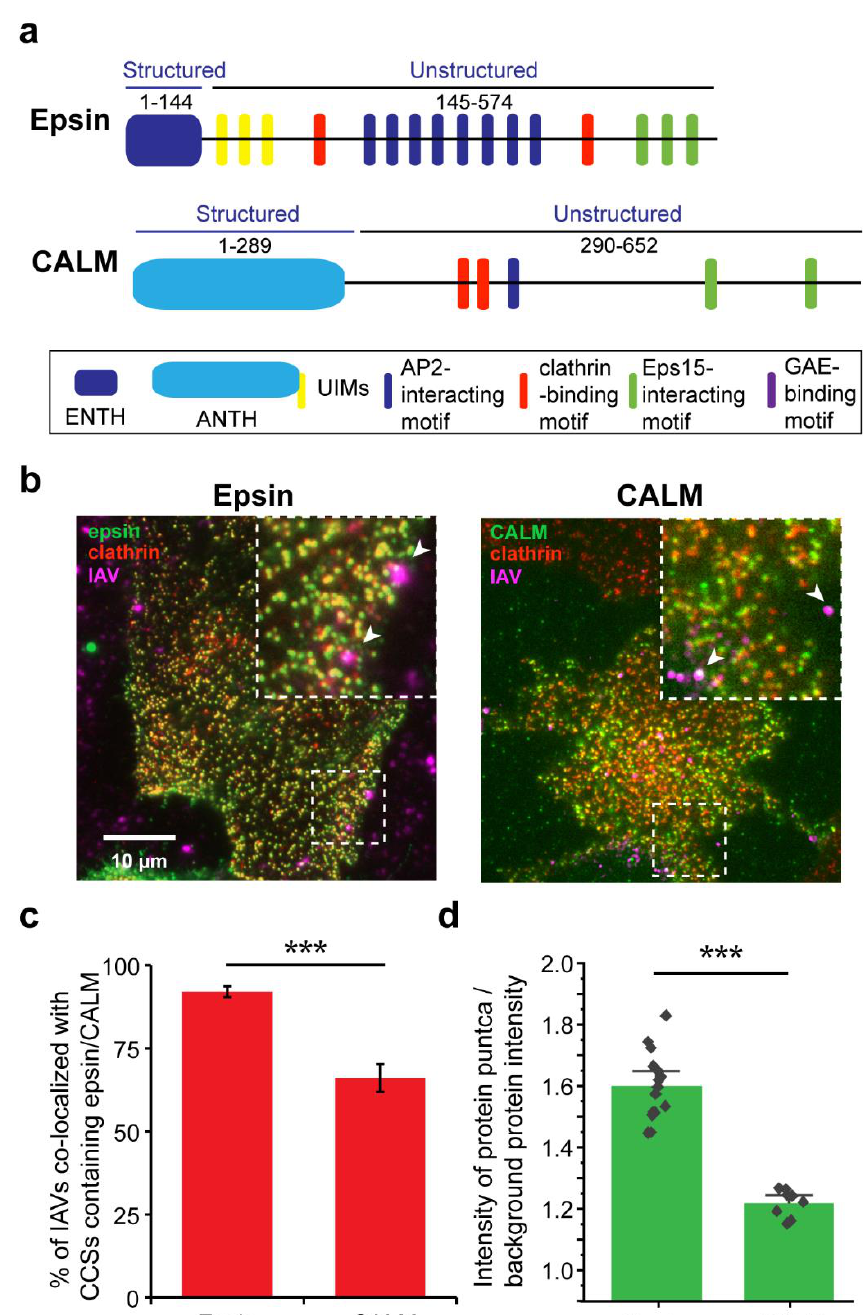
Figure 1. Colocalization of IAVs to ENTH/ANTH proteins containing CCSs. ( a ) . Domain structures of epsin and CALM. GAE: gamma-adaptin ear. ( b ) IAVs bound to surface of RPE cells overexpressing epsin-EGFP and mCherry-Clc (left), or CALM-mCherry and EGFP-Clc (right, pseudo colored). White arrows in inset shows IAVs bound to cell surface. ( c ) Percentage of IAVs colocalizing with epsin and CALM to the total number of IAVs bound to the surface. The error bars denote counting error from binomial distribution. ( d ) Ratio of puncta intensity to background intensity of proteins colocalized with surface bound IAVs. For c and d, N cells expressing epsin-EGFP were 15 and N cells expressing CALM-mCherry were 10. For c and d, N cells expressing epsin-EGFP was 15, and N cells expressing CALM-mCherry was 10. N IAVS analyzed for epsin-EGFP and CALM was 288 and 128 respectively. For c the error bars denote standard error from binomial distribution. For d the error bar denotes standard error. *** represents p <